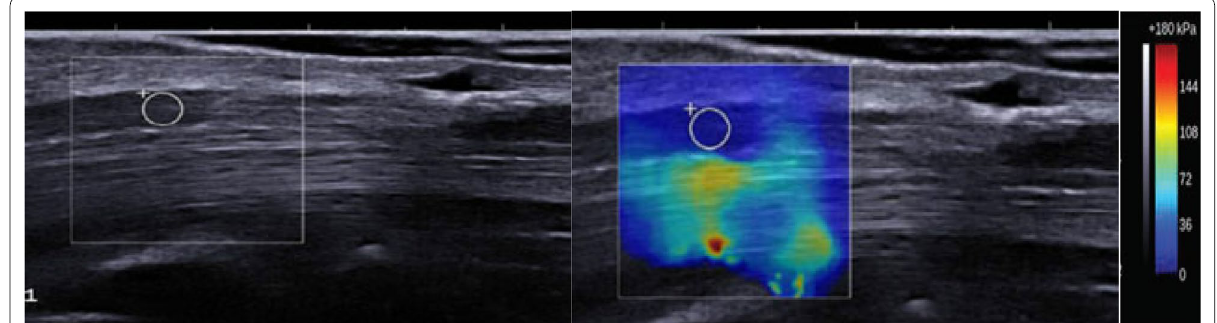
Fig. 1 A 32-year-old normal female free from symptoms of carpal tunnel syndrome with normal electrophysiological diagnostic studies. ( Left ) High-resolution conventional B-mode ultrasound normal median nerve thickness ( homogenous blue color of the median nerve and mean median nerve stiffness value